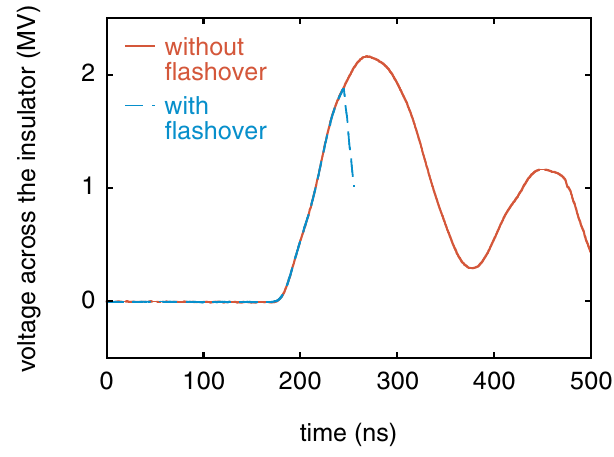
FIG. 14. (Color) Typical voltage pulses applied across an insu- lator for the flashover experiments.